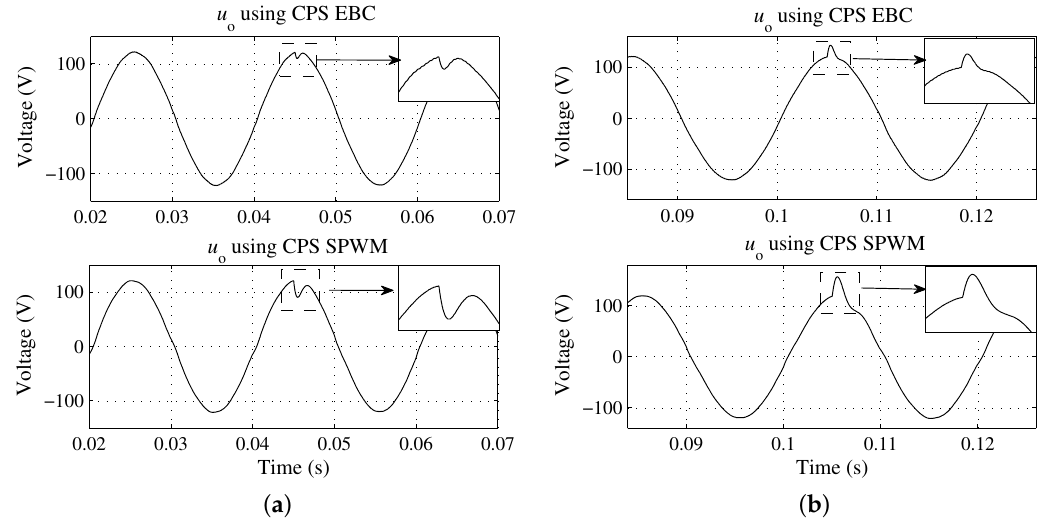
Figure 16. The simulation results of the five-level prototype under cases of load steps. ( a ) load steps as 50 Ω → 25 Ω ; and ( b ) load steps as 25 Ω → 50 Ω .